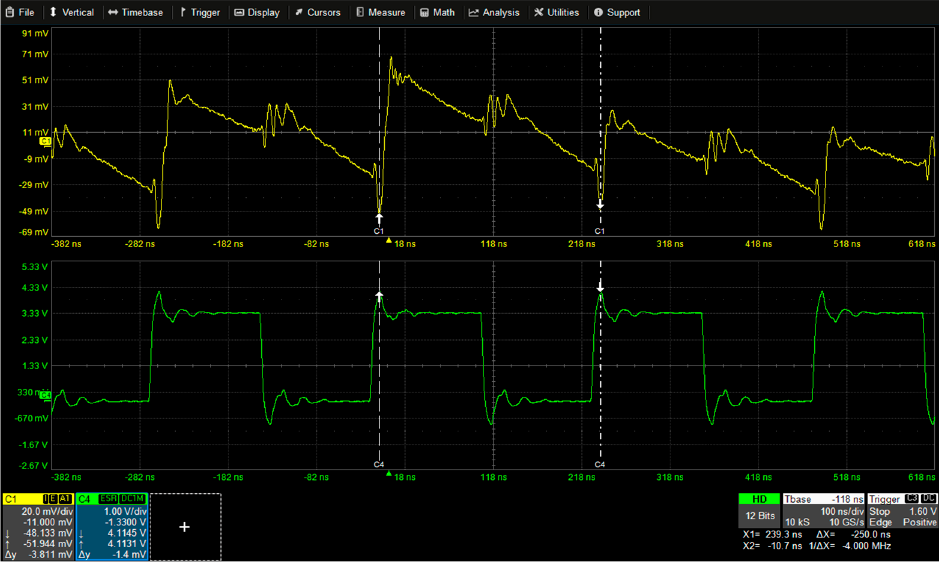
Figure 3. The power consumption pattern of the ATxmega128 (4 MHz).